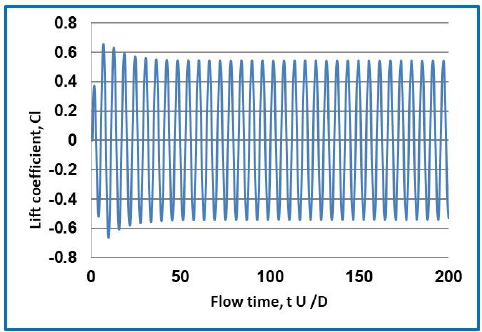
Figure 7: Lift coeflcient history at f v = 0.5 f s , crossflow vibration